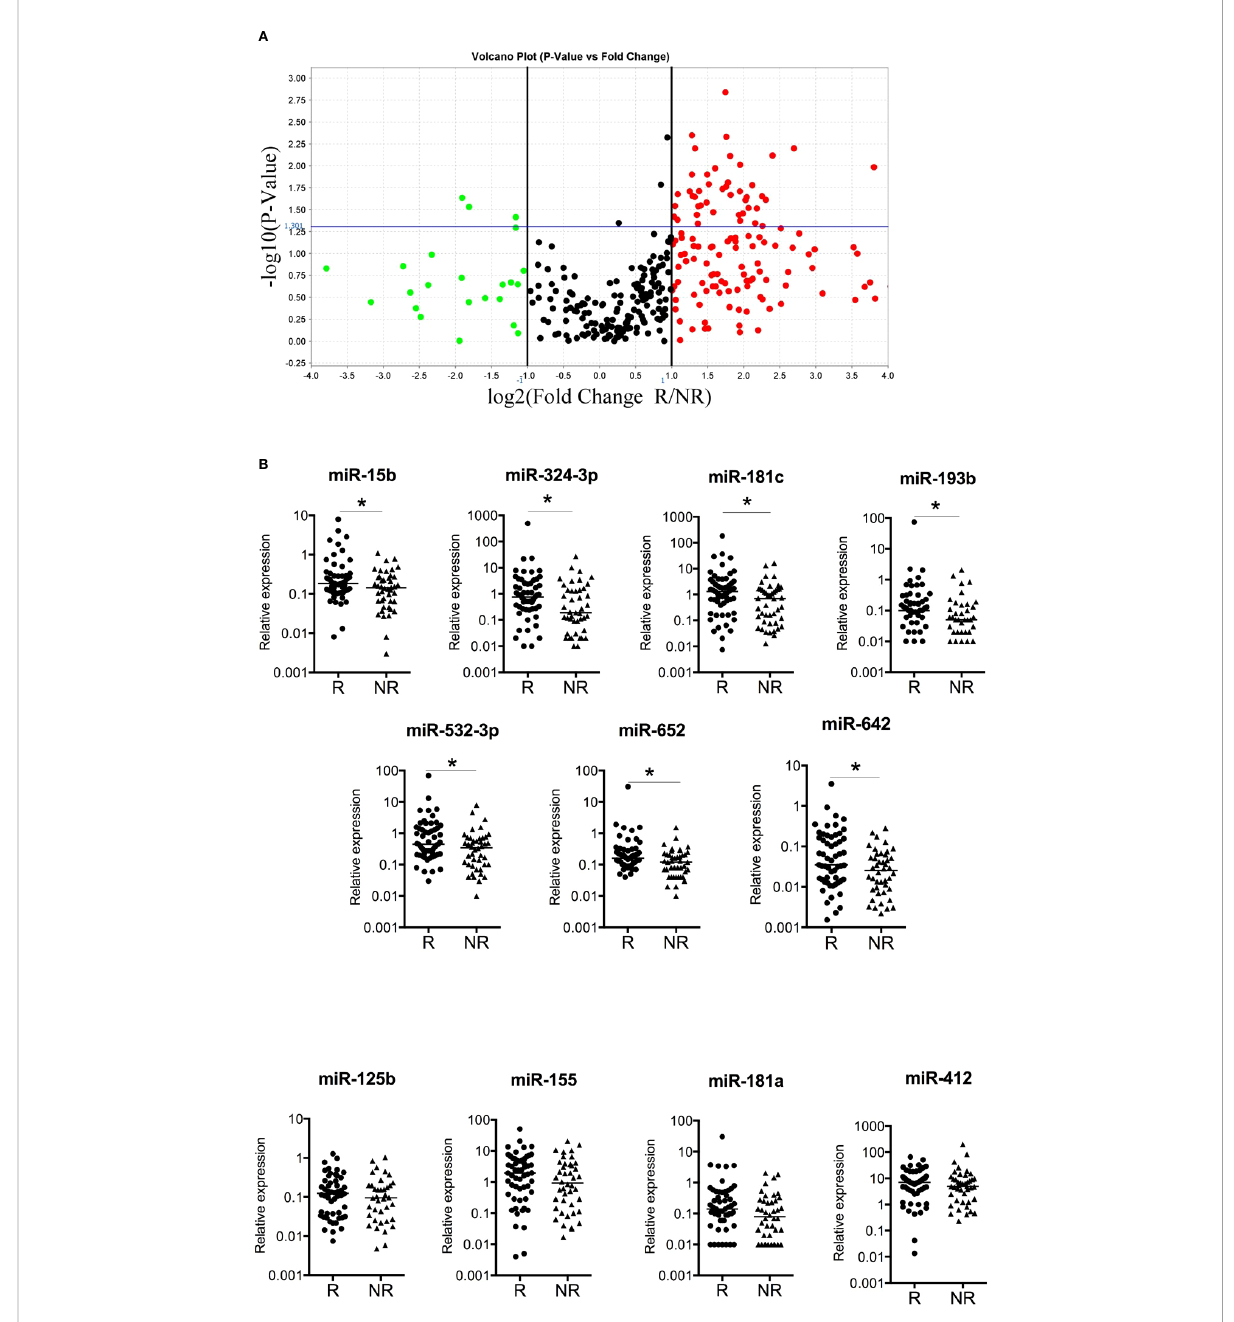
FIGURE 1 miRNAs associated with complete remission and uMRD (A) miRNAs associated with CR and BM uMRD (undetectable minimal residual disease) in previously untreated B-CLL patients. A volcano plot compares the normalized expression of miRNAs in fi rst line of treatment outcome in CR with blood and BM uMRD patients (n=8) versus no-CR with detectable MRD value patients (n=8) assessed three months after treatment. Log2 fold changes and their corresponding P-values of all genes in the microarray were taken for construction of the volcano plot. The y-axis is the negative log10 of P values (a higher value indicates greater signi fi cance) and the x-axis is the difference in expression between two experimental groups. Genes up-regulated with more than 2.5-fold change are depicted in red boxes and those downregulated with identical fold change are in green boxes. Genes above the blue line are signi fi cantly deregulated (P-value<0.05, t-test). All other genes in the array that were not deregulated are in black dots. 25 genes were identi fi ed as signi fi cantly up or downregulated. (B) The expression level of 11 miRNAs was quanti fi ed using multiplex RT-qPCR in a validation cohort of treatment-naïve B-CLL patients (n=100). R: responders, NR: non-responders. Median are plotted, *